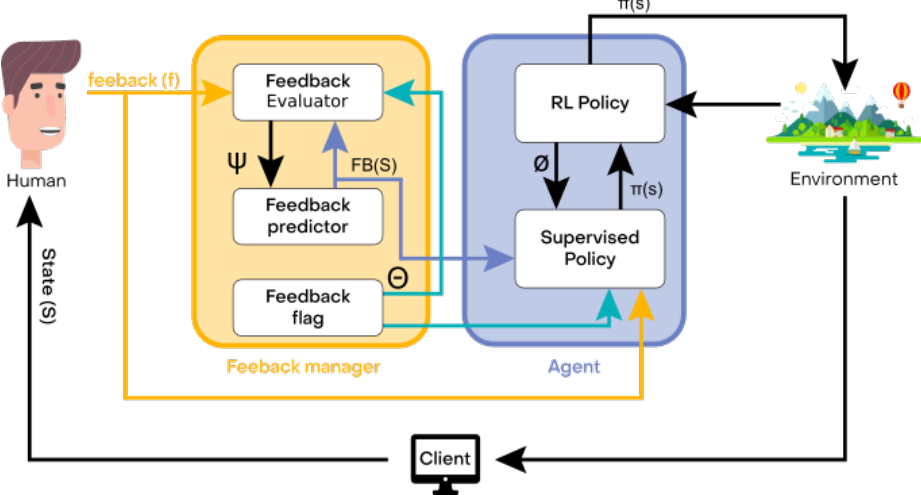
Figure 2. Proposed structure for human–AI